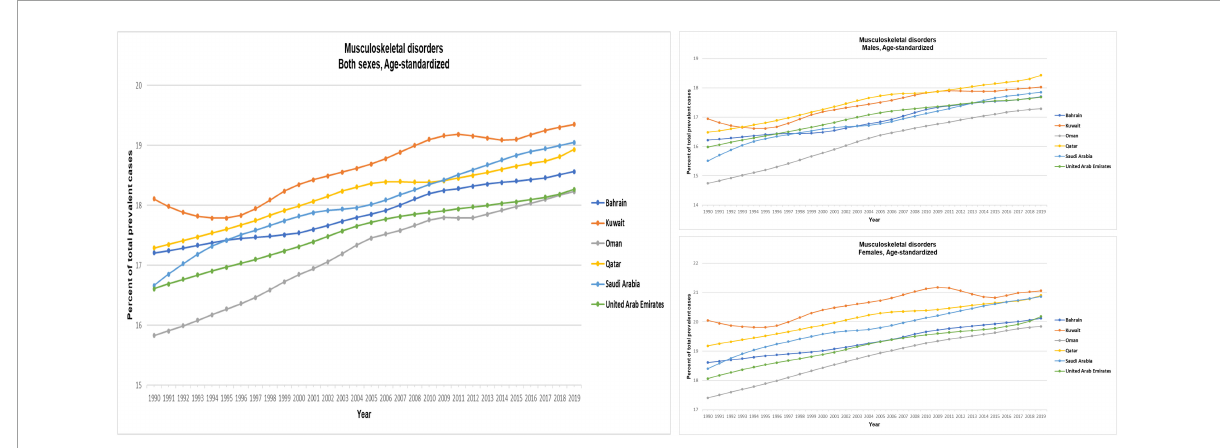
FIGURE1 Age-standardized prevalence (%) of MSK disorders for GCC countries, Global Burden of Disease 2019 study. The figure is adopted by the Institute for Health Metrics and Evaluation [IHME]